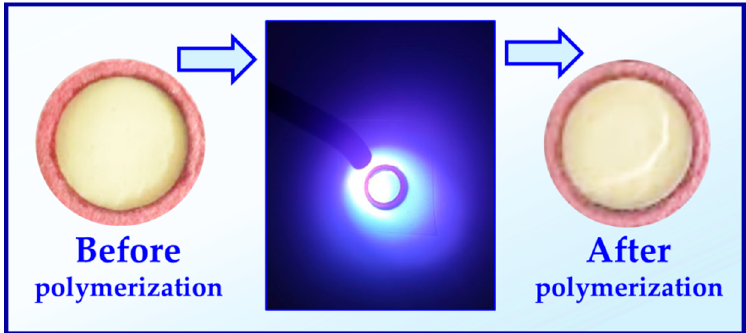
Figure 9. Color of a polymer composition composed of CQ (0.3 (wt.%)/EDB (0.5 wt.%) and Figure9. ColorofapolymercompositioncomposedofCQ(0.3(wt.%) / EDB(0.5wt.%)andBisGMA / TEGDMA BisGMA/TEGDMA (7:3) before and after photopolymerization. (7:3) before and after photopolymerization. Materials 2020 , 13 , x FOR PEER REVIEW 10 of 45